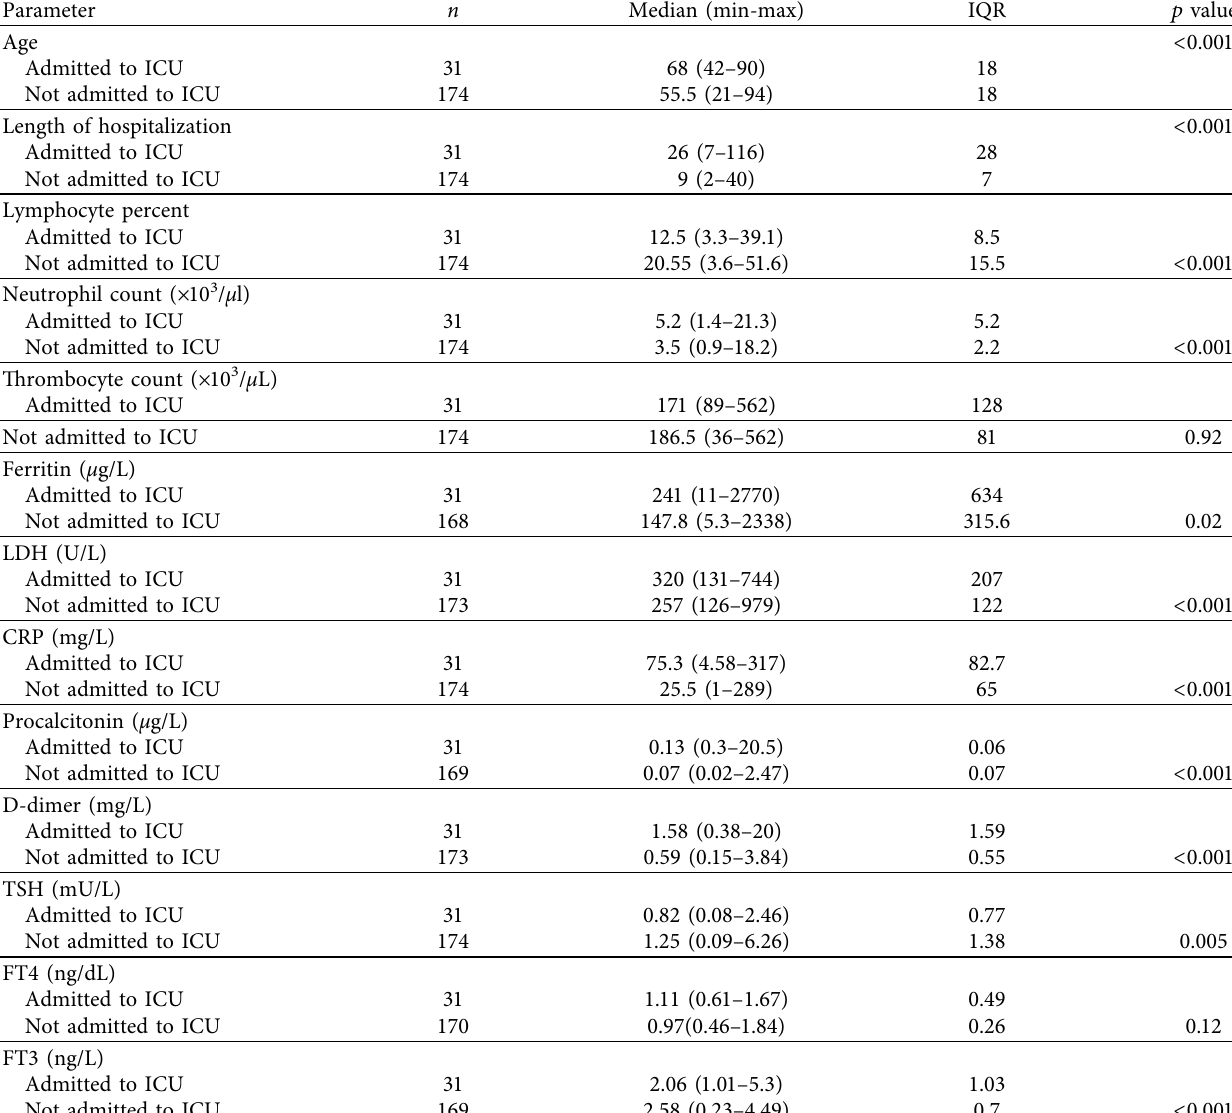
Table 4: Characteristics and laboratory parameters of patients admitted to